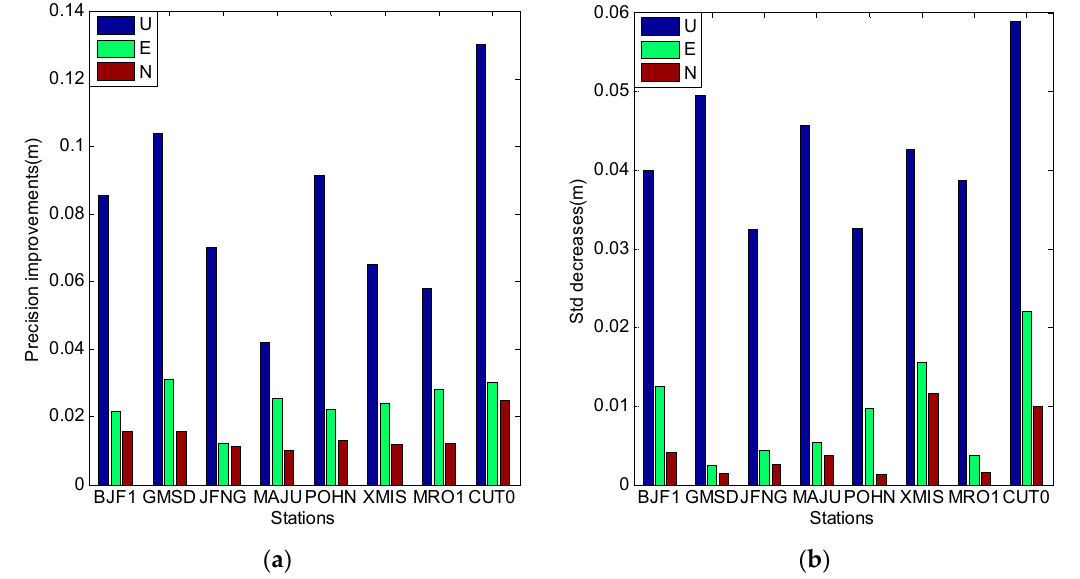
Figure 18. The SPP results estimated by using ionosphere-free combination of the first and second frequencies. ( a ) Describe precision improvements after model correction; ( b ) Describes the Std decreases after the model correction.